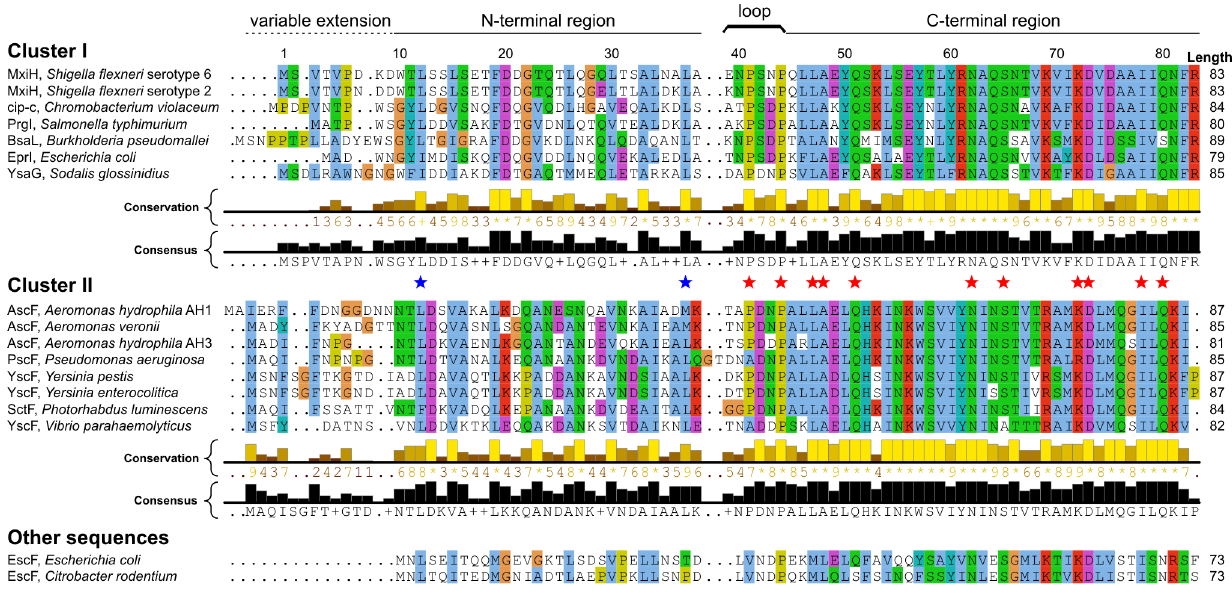
Figure 2. Multiple sequence alignment of T3SS needle proteins. Conserved residues are colored according to amino acid type following the Clustal X color scheme [75]. Highly conserved residues ( $ 12 identical amino acids in both clusters) are highlighted with a star (N-terminal region: blue; C-terminal region: red). The numbering of residues corresponds to the sequence of MxiH. Database accession identifiers for the primary sequences are given in supplementary Table S3 in Text